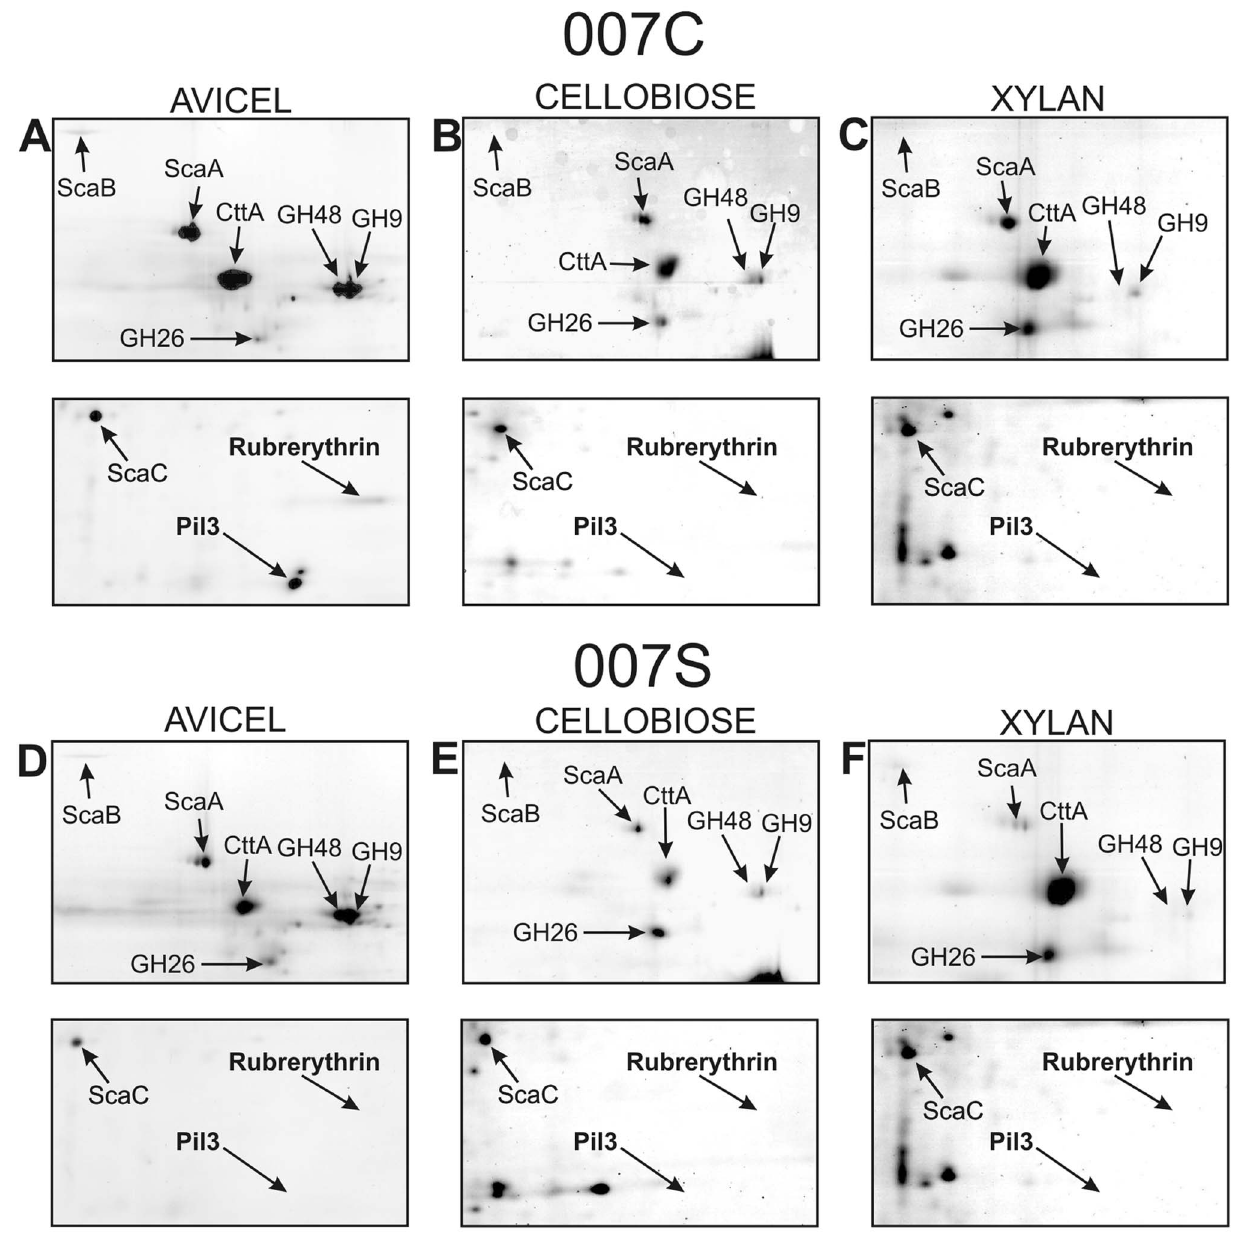
Figure 3. Impact of growth substrate on the extracellular proteome. Expanded views are show for 2D gel separations of supernatant proteins from R. flavefaciens 007C and 007S cutures grown on Avicel (7.5 days), xylan (48 hours) or cellobiose (24 hours). The arrows point to identified proteins; relative expression levels for some of these are shown in Figure 4.